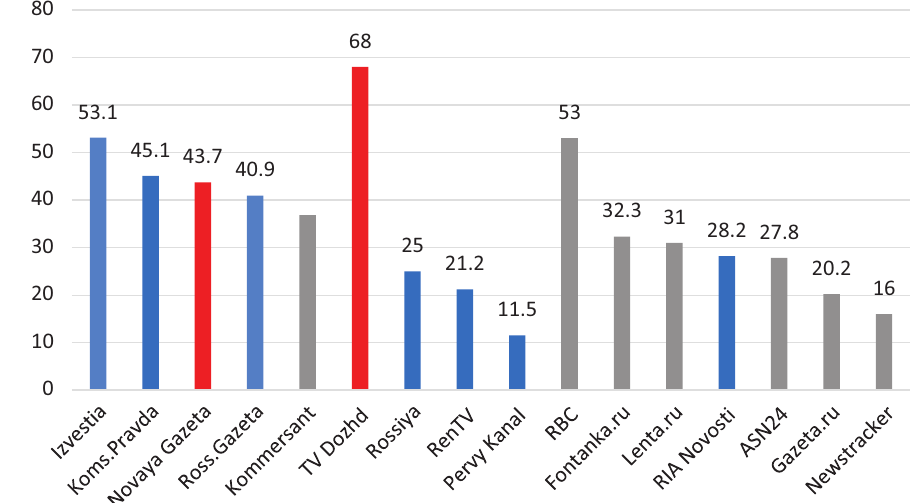
Figure 2. Percentages of publications on immigration that also discuss Covid‐19. Notes: Blue = pro‐state media; red = liberal‐oppositional media; grey = neutral/independent/undecided; Koms.Pravda = Komsomolskaya Pravda ; Ross.Gazeta = Rossiyskaya Gazeta